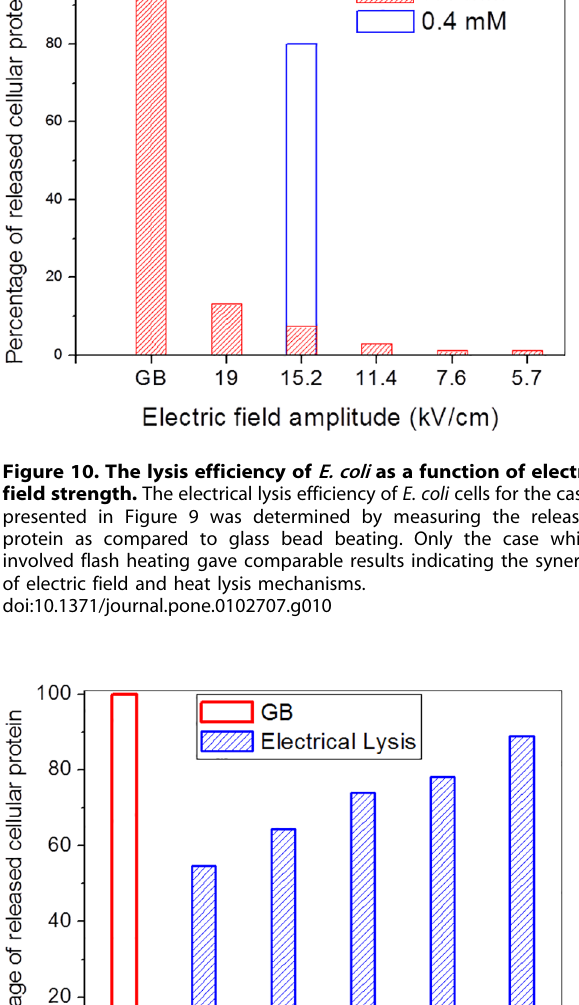
Figure 12. The two chambers are similar in terms of protein release and their lysis performance is comparable to the GB beating. Therefore the electrode type does not affect lysis performance of the chambers for protein release. Figure 9. The current response envelope of lysis chambers